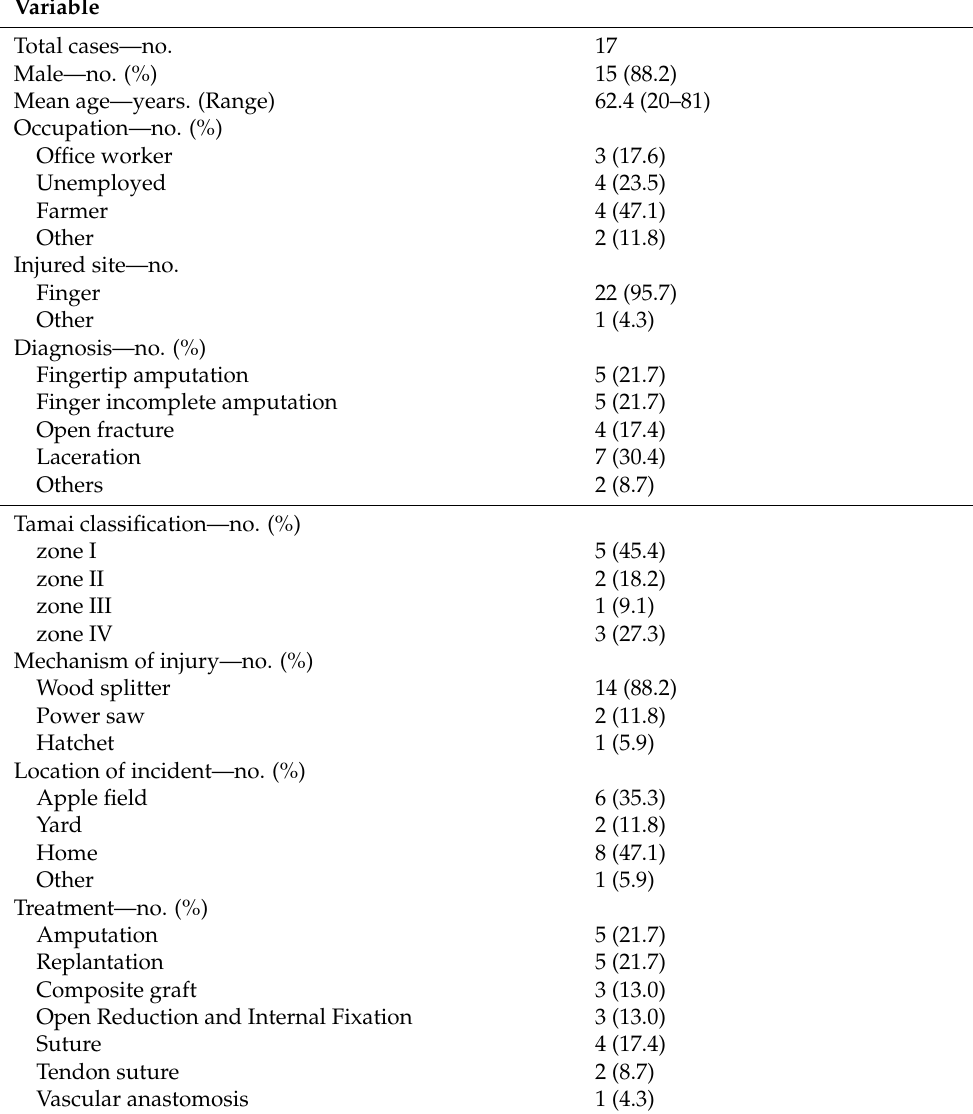
Table 1. Patient characteristics (17 patients with 22 finger injuries and one elbow